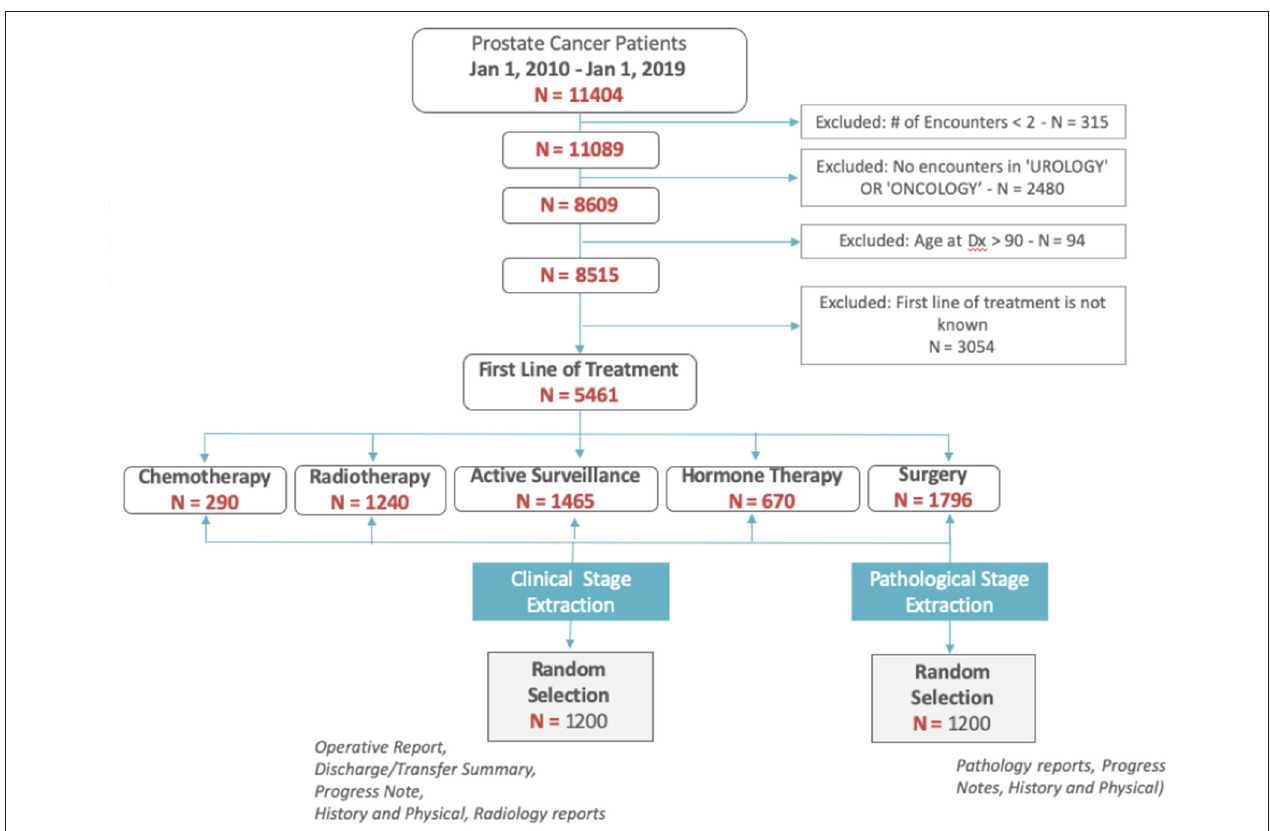
FIGURE 1 | Cohort selection